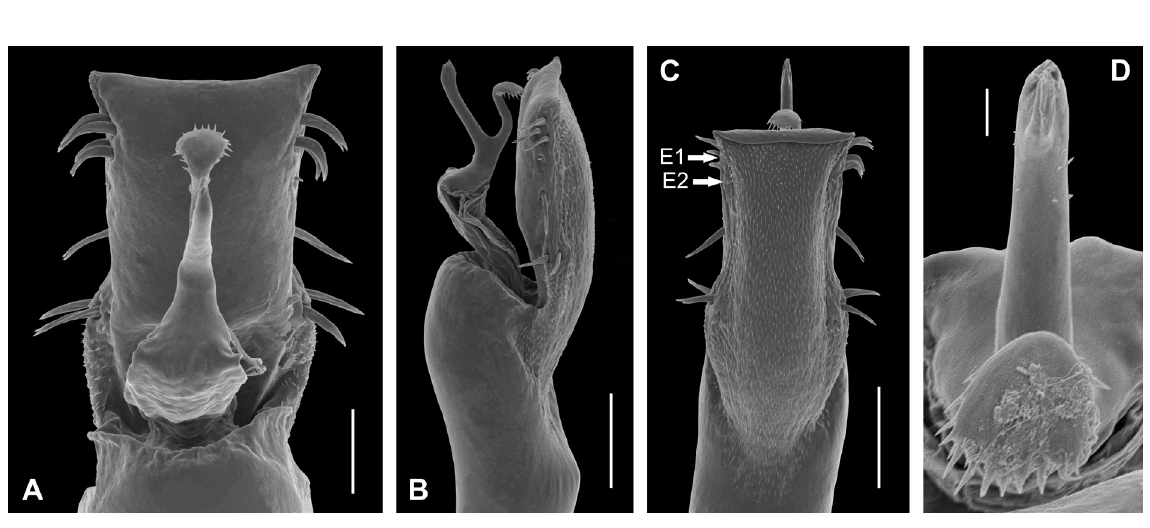
bars: A = 50 μm; B–C = 100 μm; D = 10